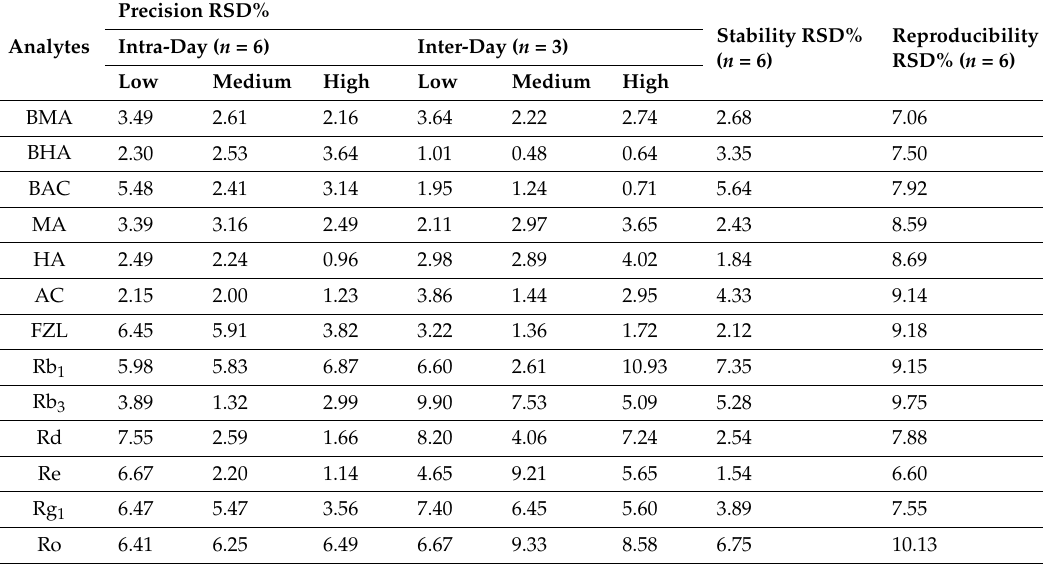
Table 4. Precision, stability, and reproducibility of 13